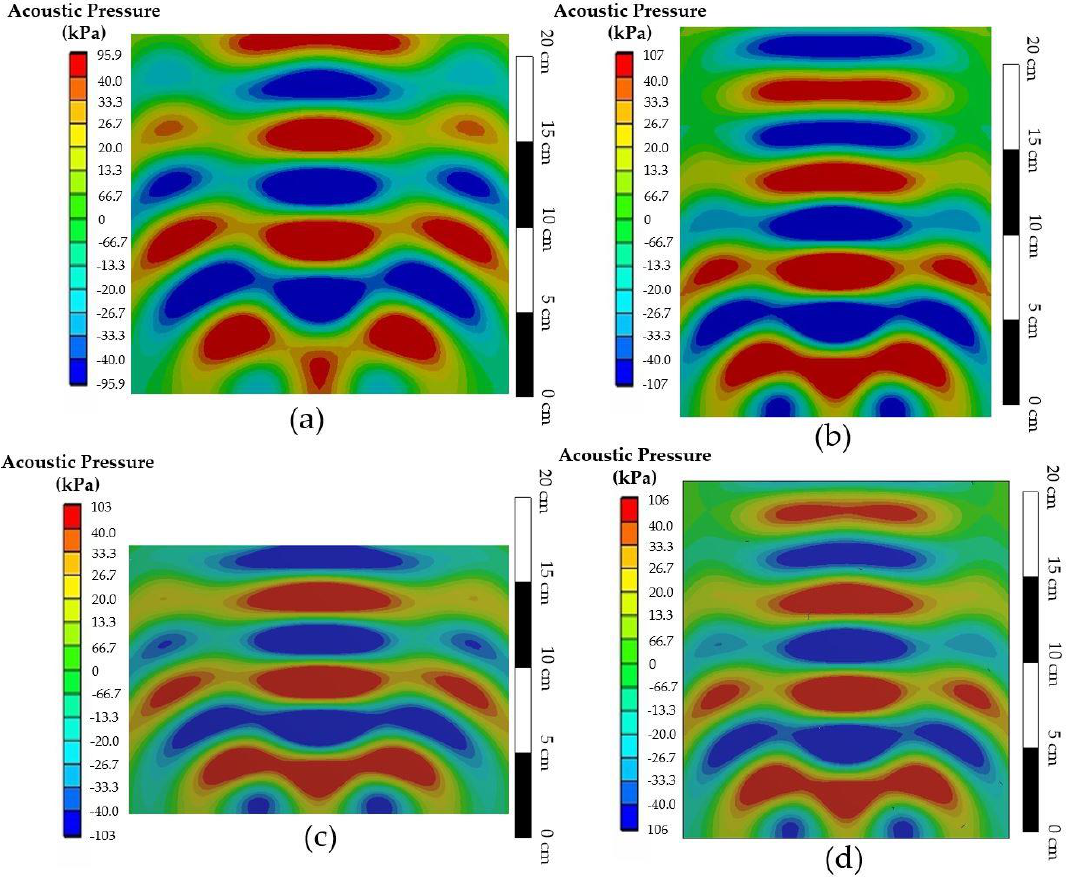
Figure 7. Acoustic pressure distribution in vertical plane of ( a ) model A, ( b ) model B, ( c ) model C, and ( d ) model D.